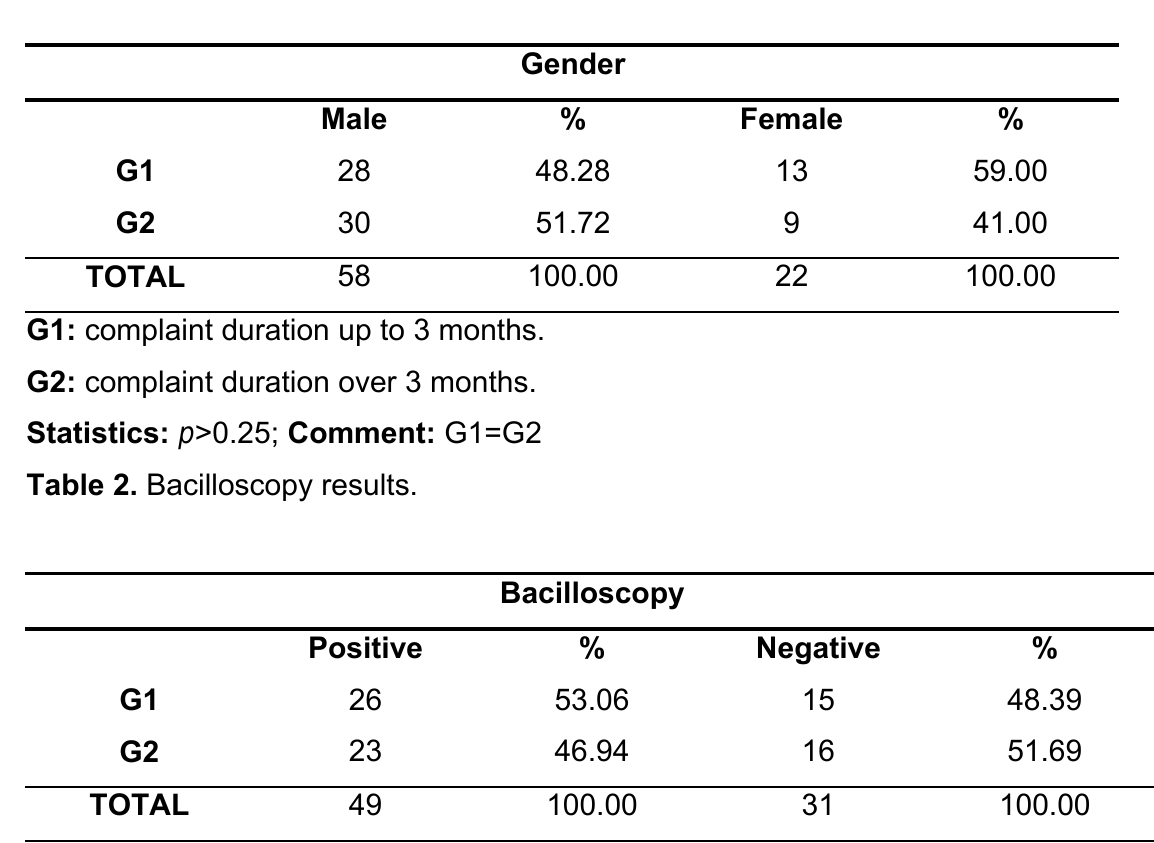
Table 1. Gender distribution of patients with pulmonary tuberculosis.